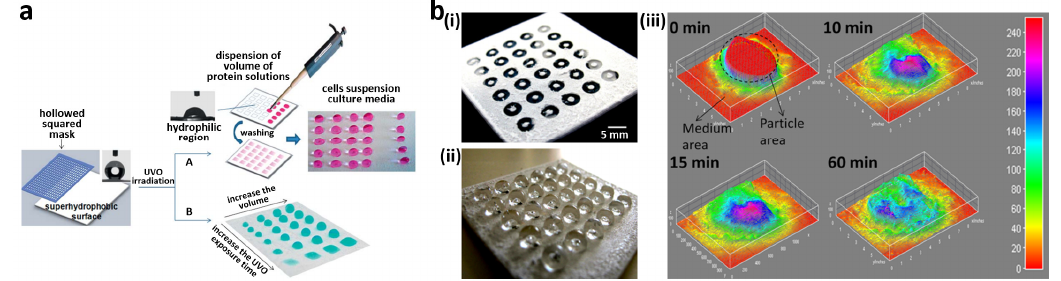
Figure 12. ( a ) High ‐ throughput screening platform using a superhydrophobic surface patterned with hydrophilic spots; ( b ) ( i ) Superhydrophobic surface patterned with hydrophilic rings for high ‐ throughput assay; ( ii ) Hydrogel ‐ and phosphate ‐ buffered saline (PBS) droplet ‐ loaded substrate; ( iii ) Surface plots of release profiles of the fluorescein isothiocyanate labeled bovine serum albumin (BSA ‐ FITC) from alginate hydrogels obtained by the acquisition of fluorescent microscopy images. Reproduced from [19,173] with permission by American Chemical Society, Copyright 2011, 2013.